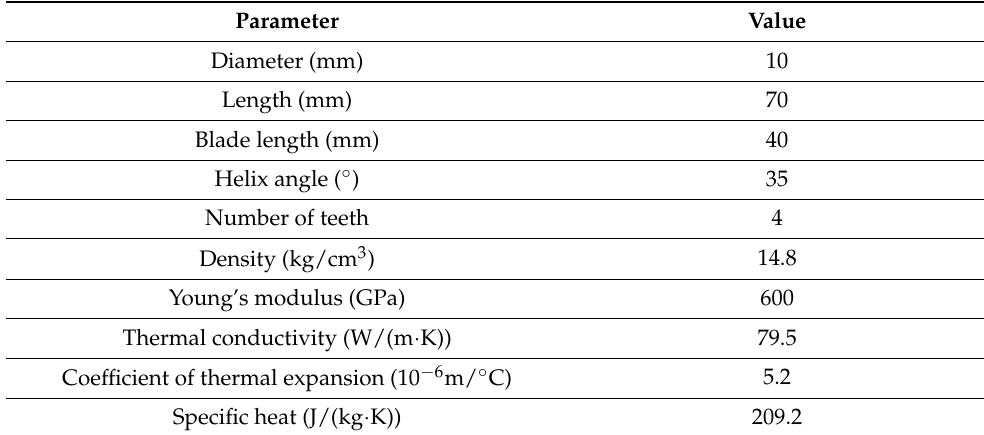
Table 1. Geometric parameters and physical properties of the test tool.